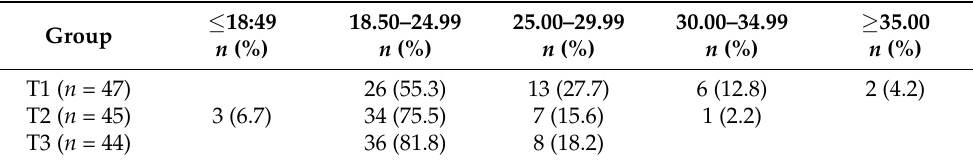
Table 5. Weight status assessment by BMI (kg/m 2 ) according to WHO. ≤ Group